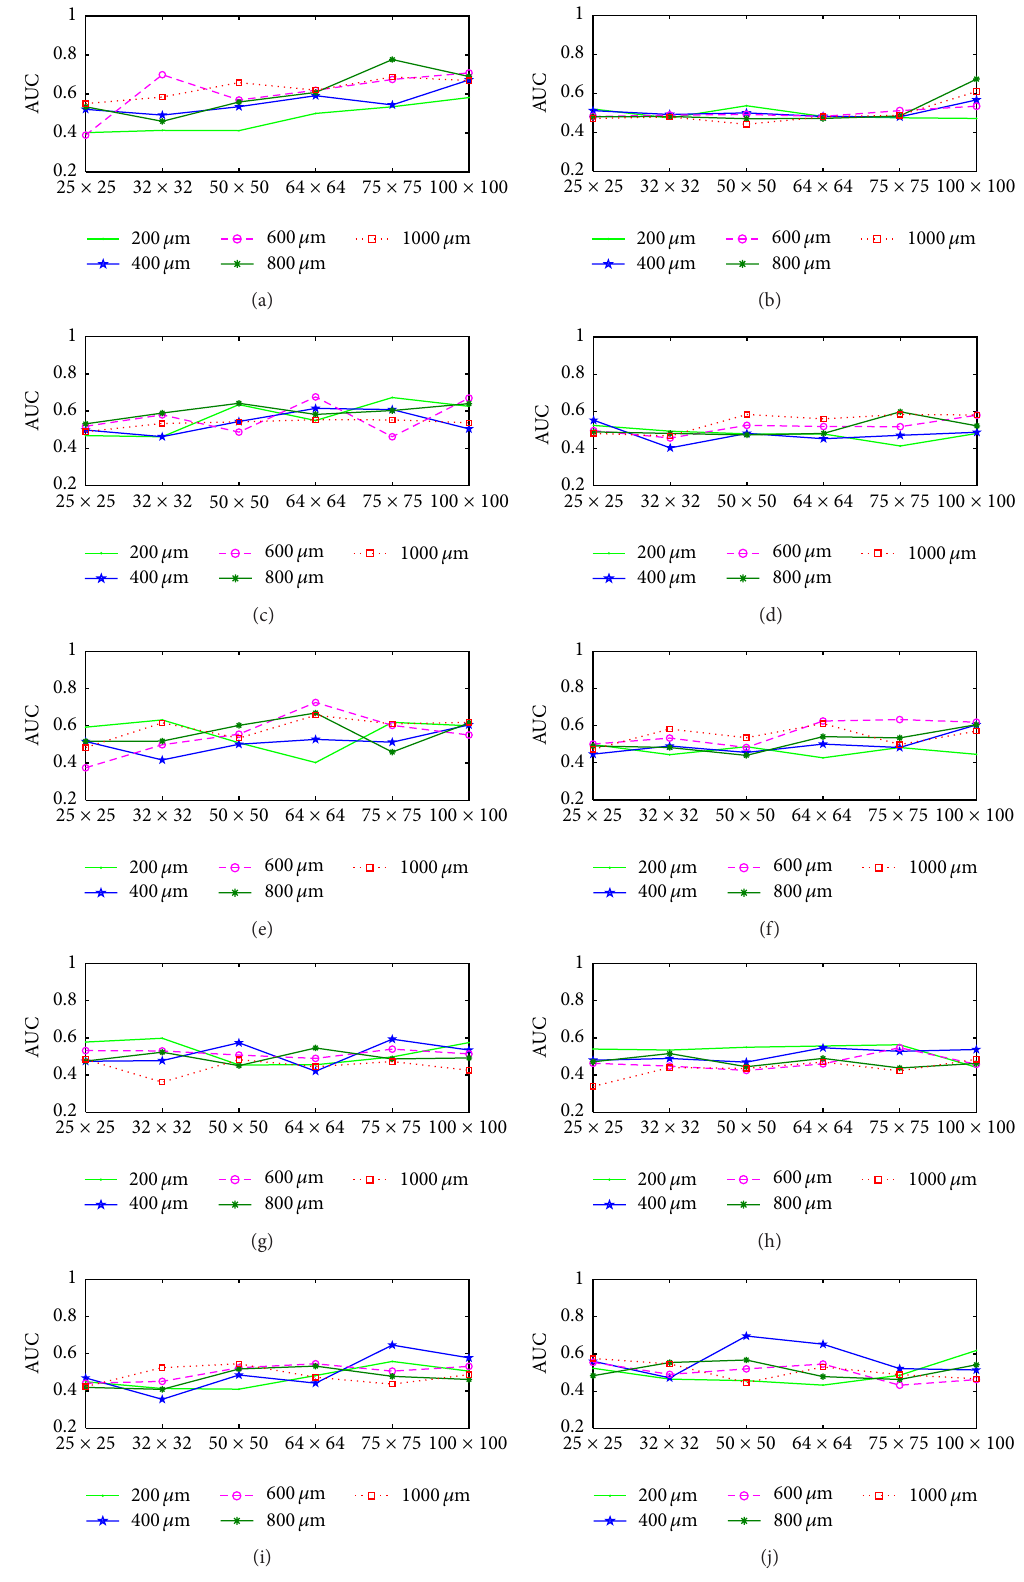
Figure 3: The effect of pixel resolution and integration scale on the performance of the texture methods with the LSVM (a, c, e, g, i), the NLSVM (b, d, f, h, j), (a)-(b) LBP, (c)-(d) LDN, (e)-(f) HOG, (g)-(h) HAR, and (i)-(j)